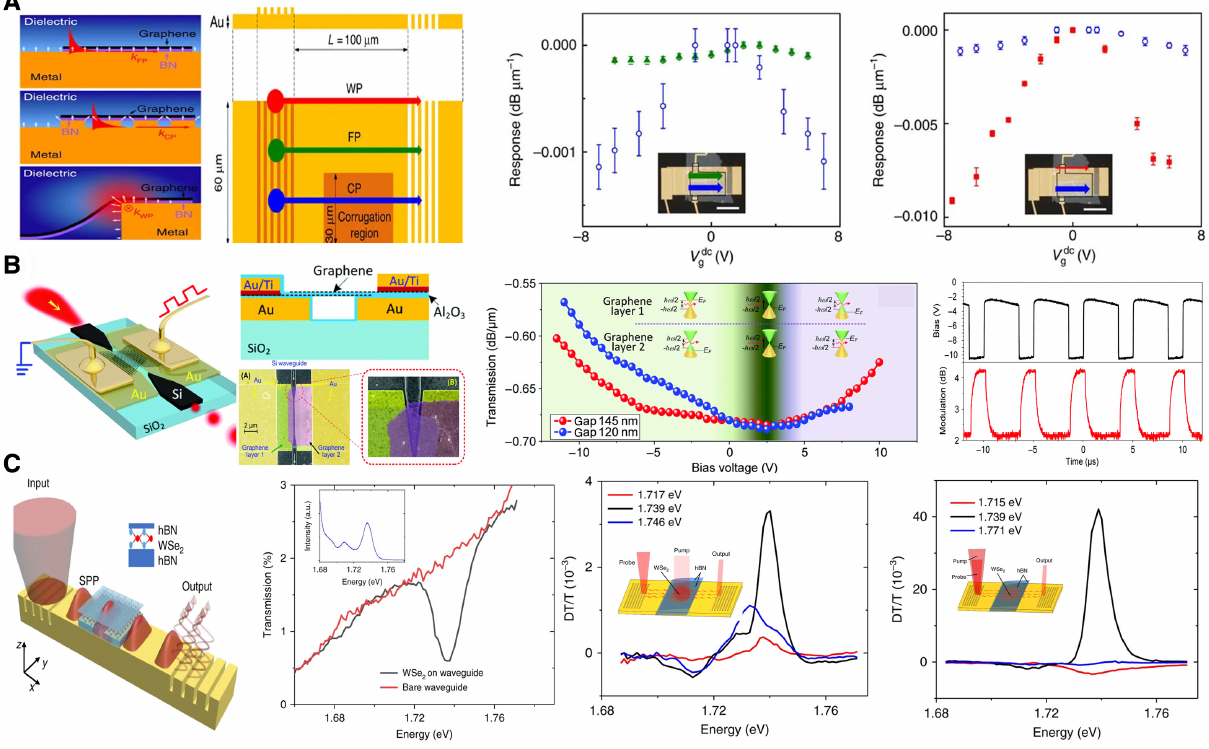
Figure 7: Plasmonic waveguide optical modulators. (A) Three different SPP modes supported by different structures, which are flat plasmons, corrugated plasmons, and wedge plasmons, respectively. The highest modulation depth of 0.03 dB/ μ m is reached for the wedge plasmons. (B) An efficient modulator based on the leaky mode of plasmonic slot waveguides. The leaky mode is achieved by optimization of the hybrid waveguide to ensure a low insertion loss of 0.68 dB/ μ m. The modulation depth is 0.13 dB/ μ m, and modulation bandwidth is 200 kHz. (C) Plasmonic modulator based on